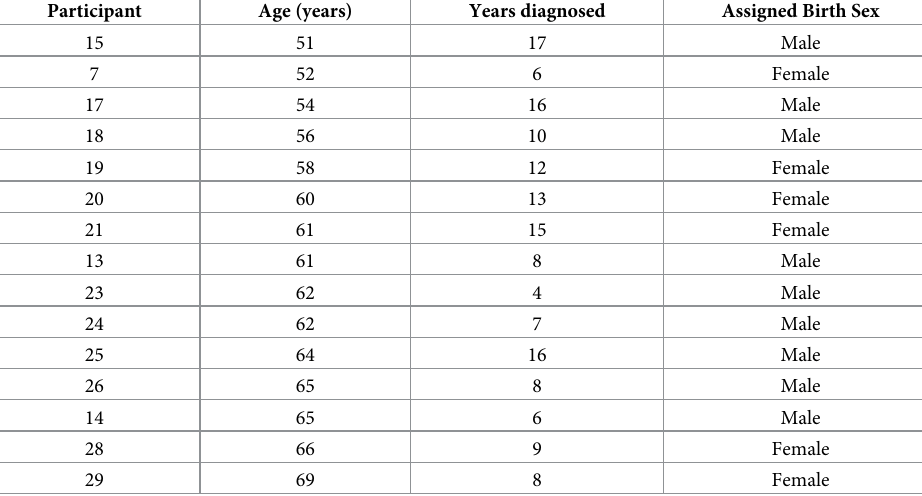
Table 2. Targeted immunoassays participant demographics.